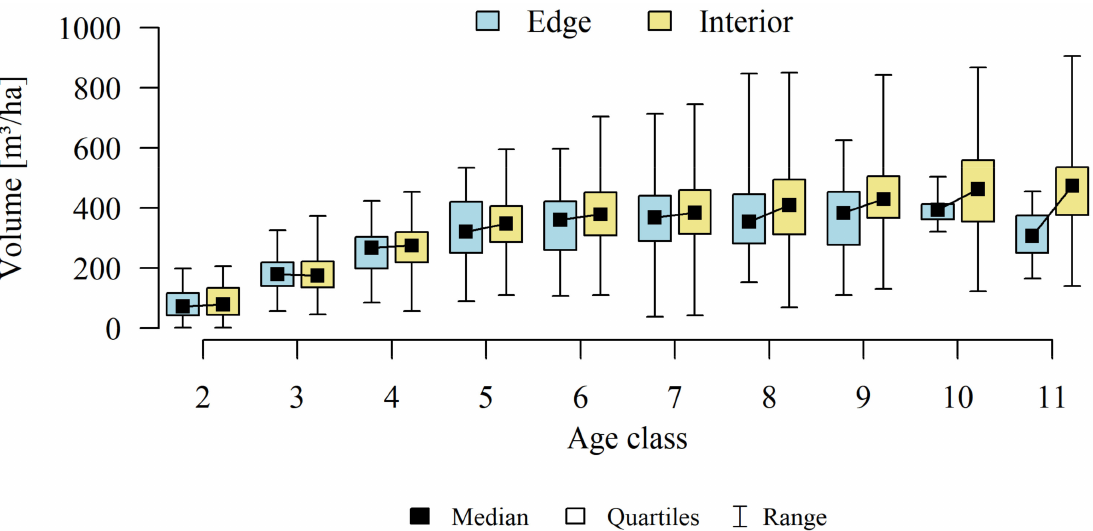
Figure 5. Results of statistics calculated for the growing stock volume density of pine stands on the FMBF site, divided into the edge and interior zone.